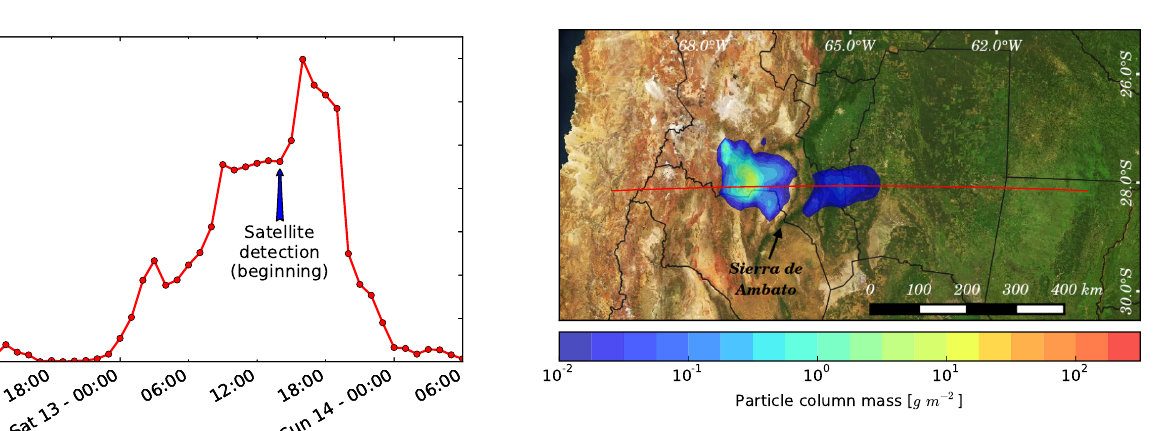
Figure 15. FALL3D output column mass on 13 June at 23:00UTC using the default configuration. The transport of dust aerosols is partly blocked by the orographic barrier Sierra de